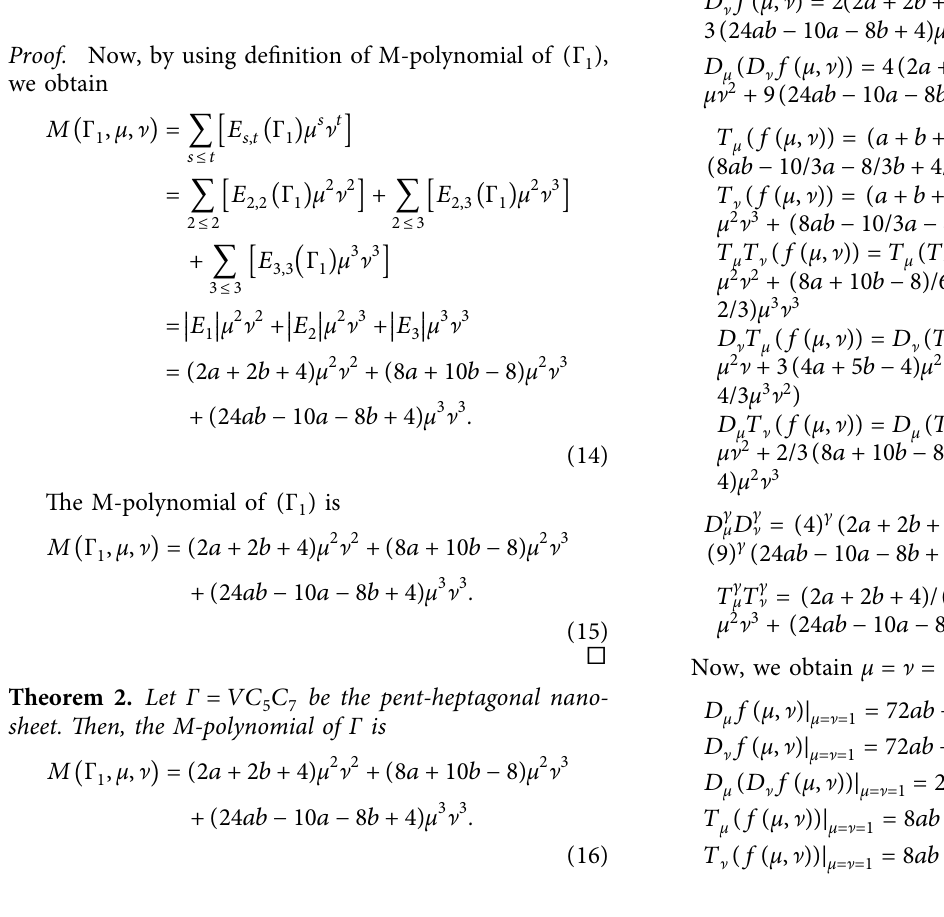
Figure 2: Pent-heptagonal nanosheet HC